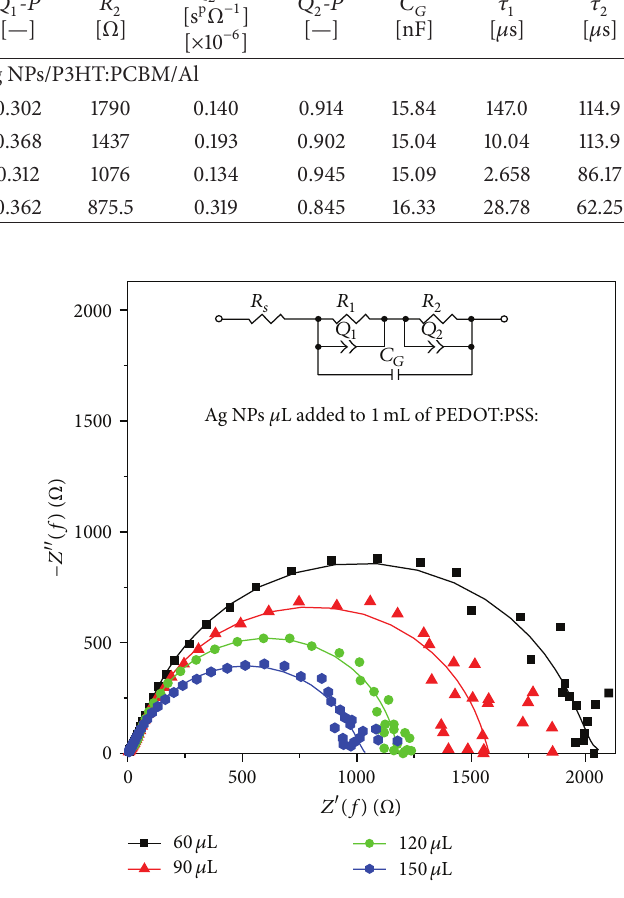
PCBM/Al device with 60, 90, 120, and 150 𝜇 L of silver NPs in 1 mL of PEDOT:PSS layer under illumination devices along with fit results and equivalent circuit of devices. 𝑅 𝑆 represents the series resistance, 𝑅 is resistance, and 𝐶 𝐺 is capacitance between anode and cathode, 𝑄 = 1/( T ⋅ (𝑗 ⋅ 𝜔) 𝑝 ) is constant phase element of investigated layer, where 𝑇 and |𝑝| ≤ 1 are parameters. When 0 < 𝑝 < 1 then the parameters correspond to some distribution of charge transport processes rather than to a single